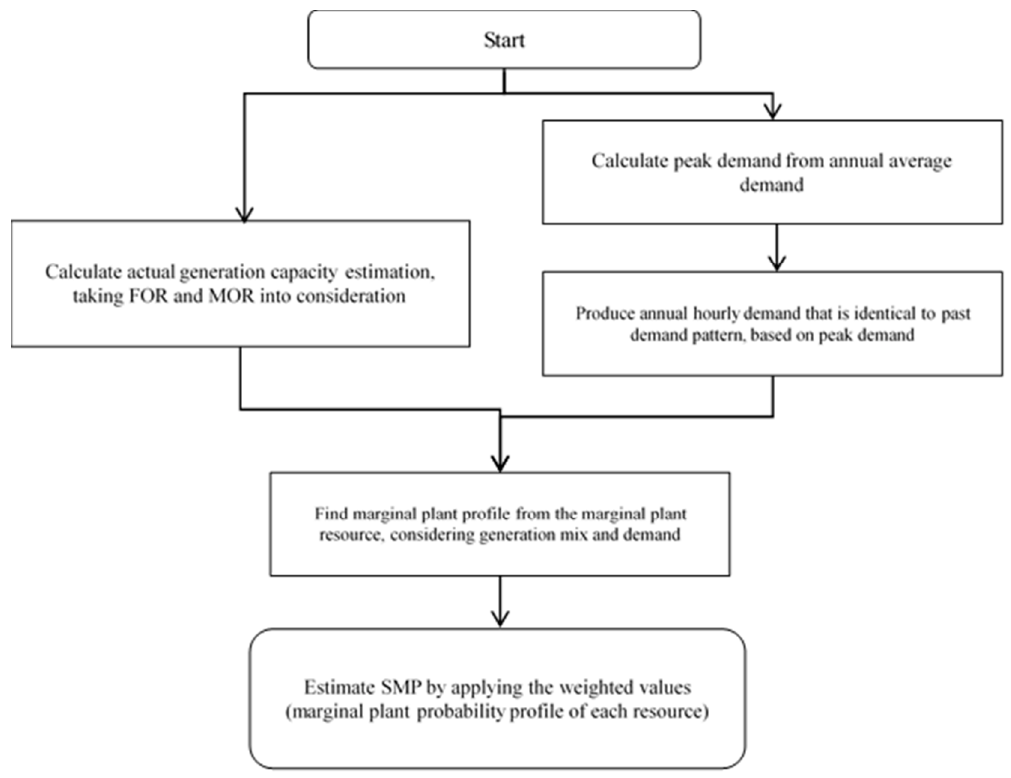
Figure 2. Schematic diagram of the SMP forecast methodology.